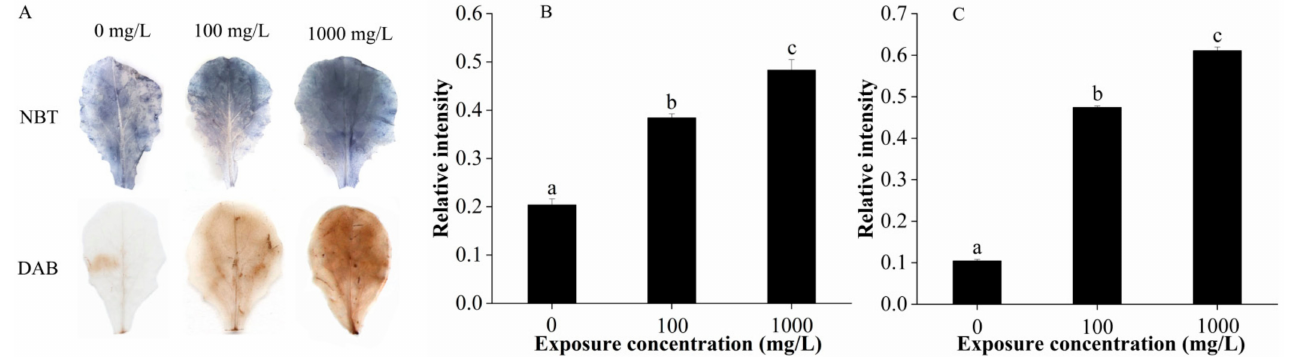
Figure 3. Generation of O 2 − and H 2 O 2 determined by NBT and DAB dye ( A ); the corresponding quantitative results of O 2 − ( B ) and H 2 O 2 ( C ) generation in lettuce leaves after 15 days of foliar exposure to CuO-NPs (0, 100, and 1000 mg/L). Values are expressed as the mean of three replicates ( ± SD) for each treatment; the different lowercase letters (a, b, and c) indicate significant difference at p < 0.05 among different exposure